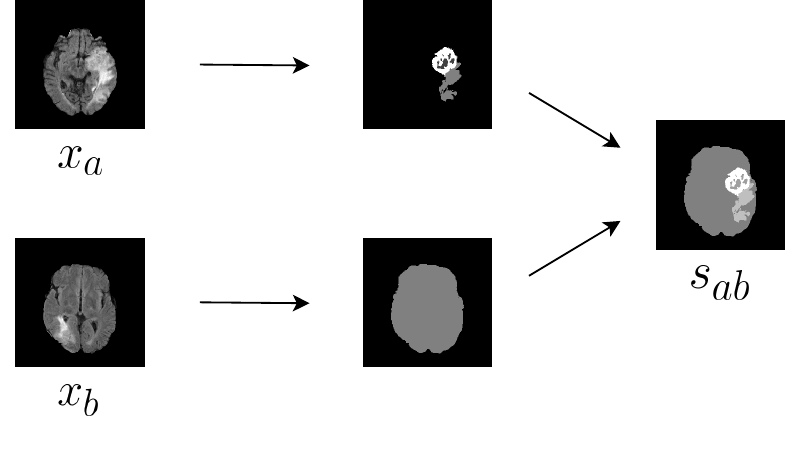
Figure 3. Composition of the label s ab